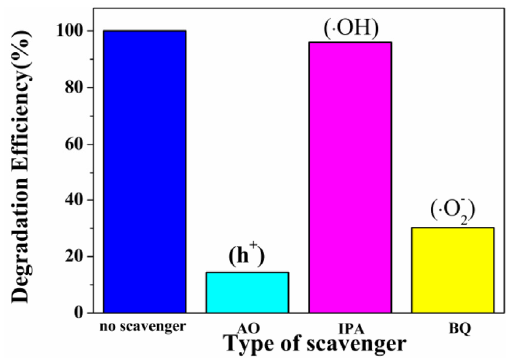
Figure 8. Trapping experiment of active species during the photocatalytic degradation of MO over W 18 O 49 (6 h) sample under visible light irradiation.